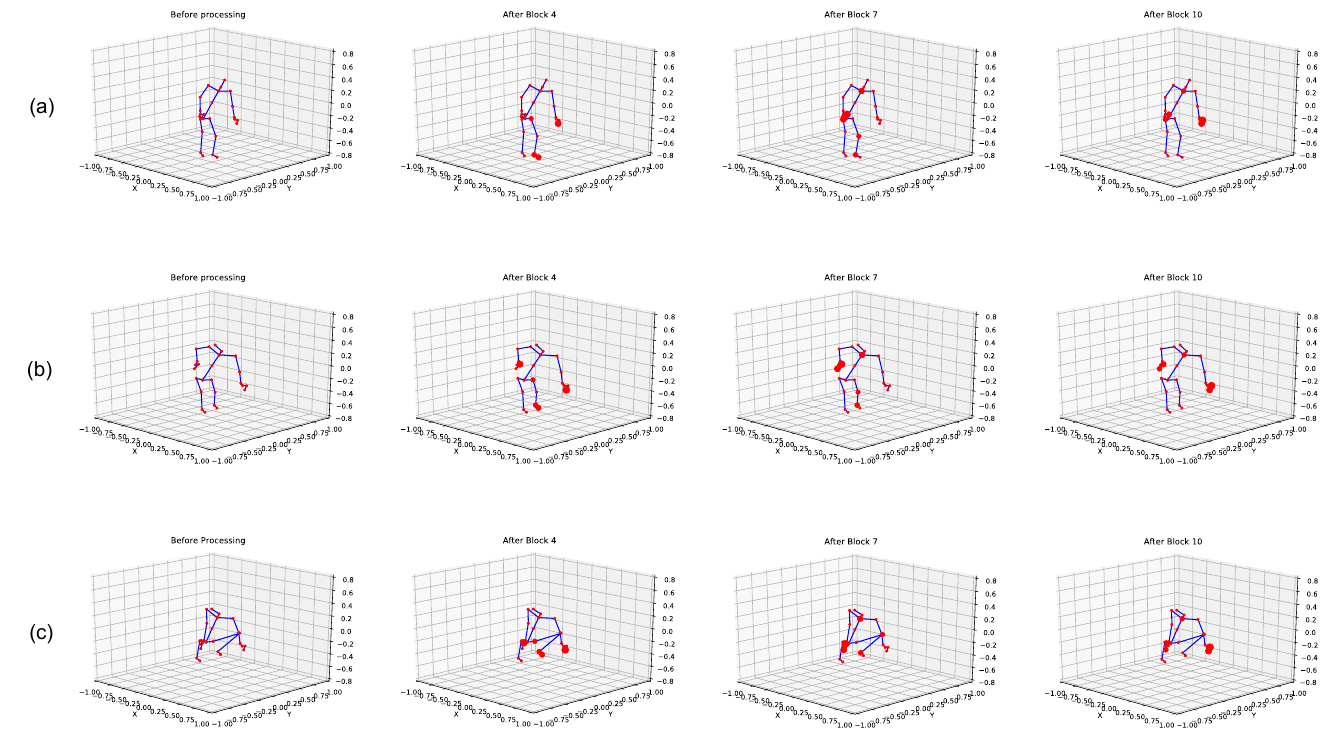
Figure 7. Visualization of feature extraction by STGCN. ( a – c ) represents the features extracted at different